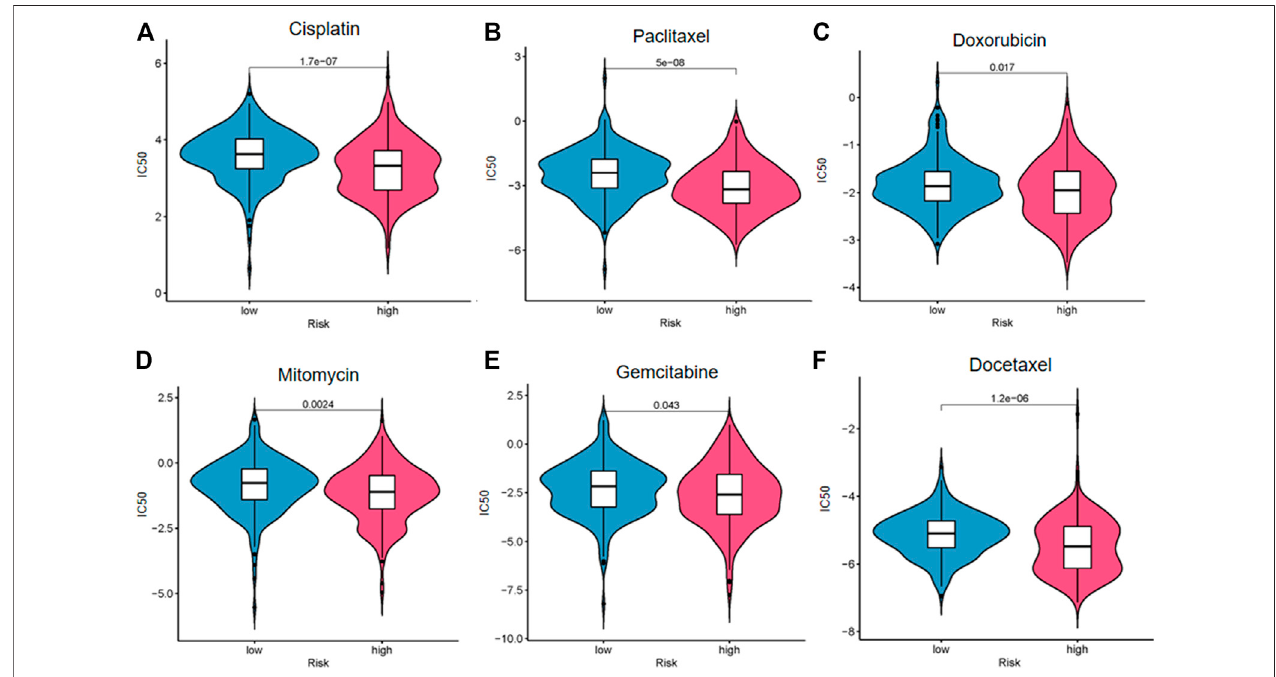
FIGURE 9 | Drug sensitivity analysis of cisplatin (A) , paclitaxel (B) , doxorubicin (C) , mitomycin (D) , gemcitabine (E) , and docetaxel (F) .